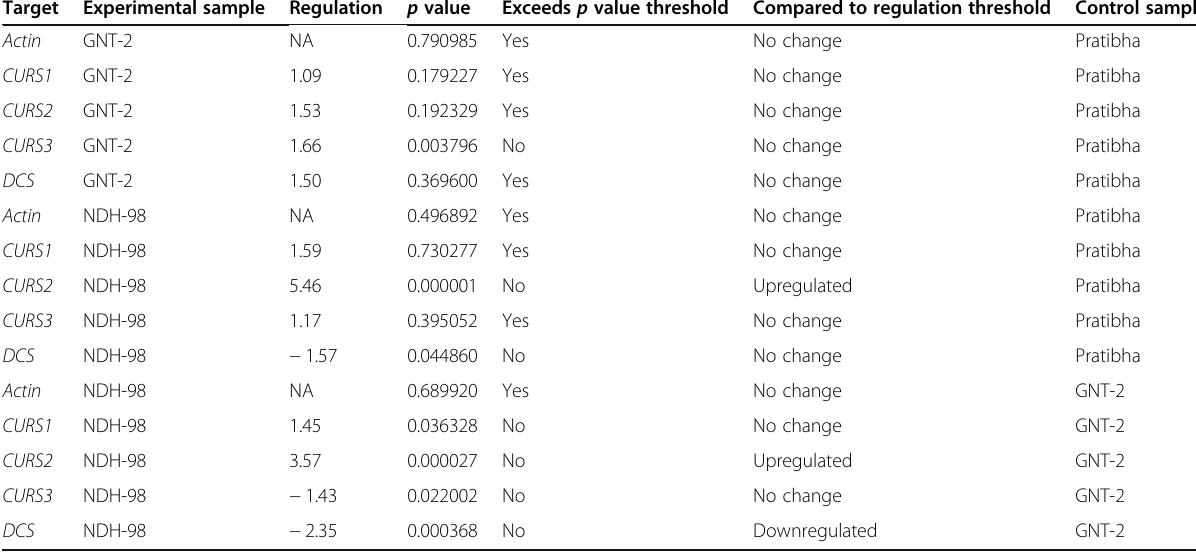
Table 2 DCS and CURS s gene regulation in turmeric rhizome over growth stages Target Experimental sample Regulation p